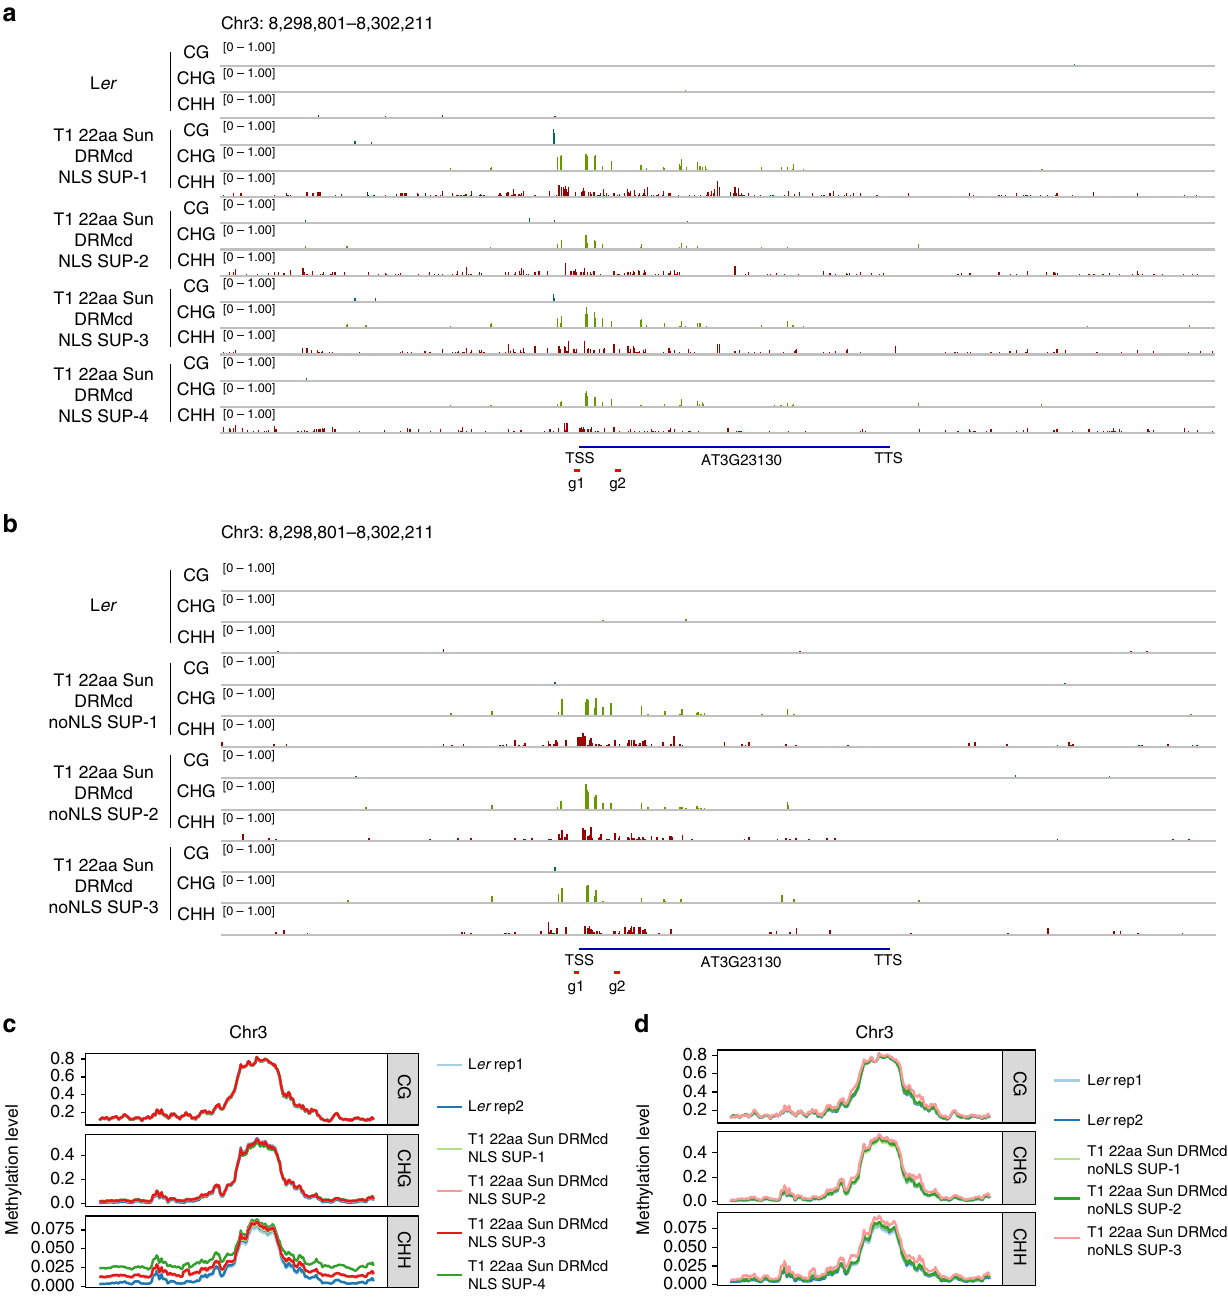
Fig. 5 SunTag-mediated methylation targeting of the SUPERMAN locus. a WGBS tracks for all 3 sequence contexts are shown at the SUP locus for L er and 4 independent T1 lines of 22aa SunTag NtDRMcd NLS SUP. Red bars indicate the positions of the 2 gRNAs targeting SUP . TSS transcription start site, TTS transcription termination site. b WGBS tracks for all 3 sequence contexts are shown at the SUP locus for L er and 3 independent T1 lines of 22aa SunTag NtDRMcd noNLS SUP. c Chromosome 3 metaplots of CG, CHG, and CHH methylation levels in 2 different L er plants and 4 independent T1 lines of 22aa SunTag NtDRMcd NLS SUP. d Chromosome 3 metaplots of CG, CHG, and CHH methylation levels in 2 different L er plants and 3 independent T1